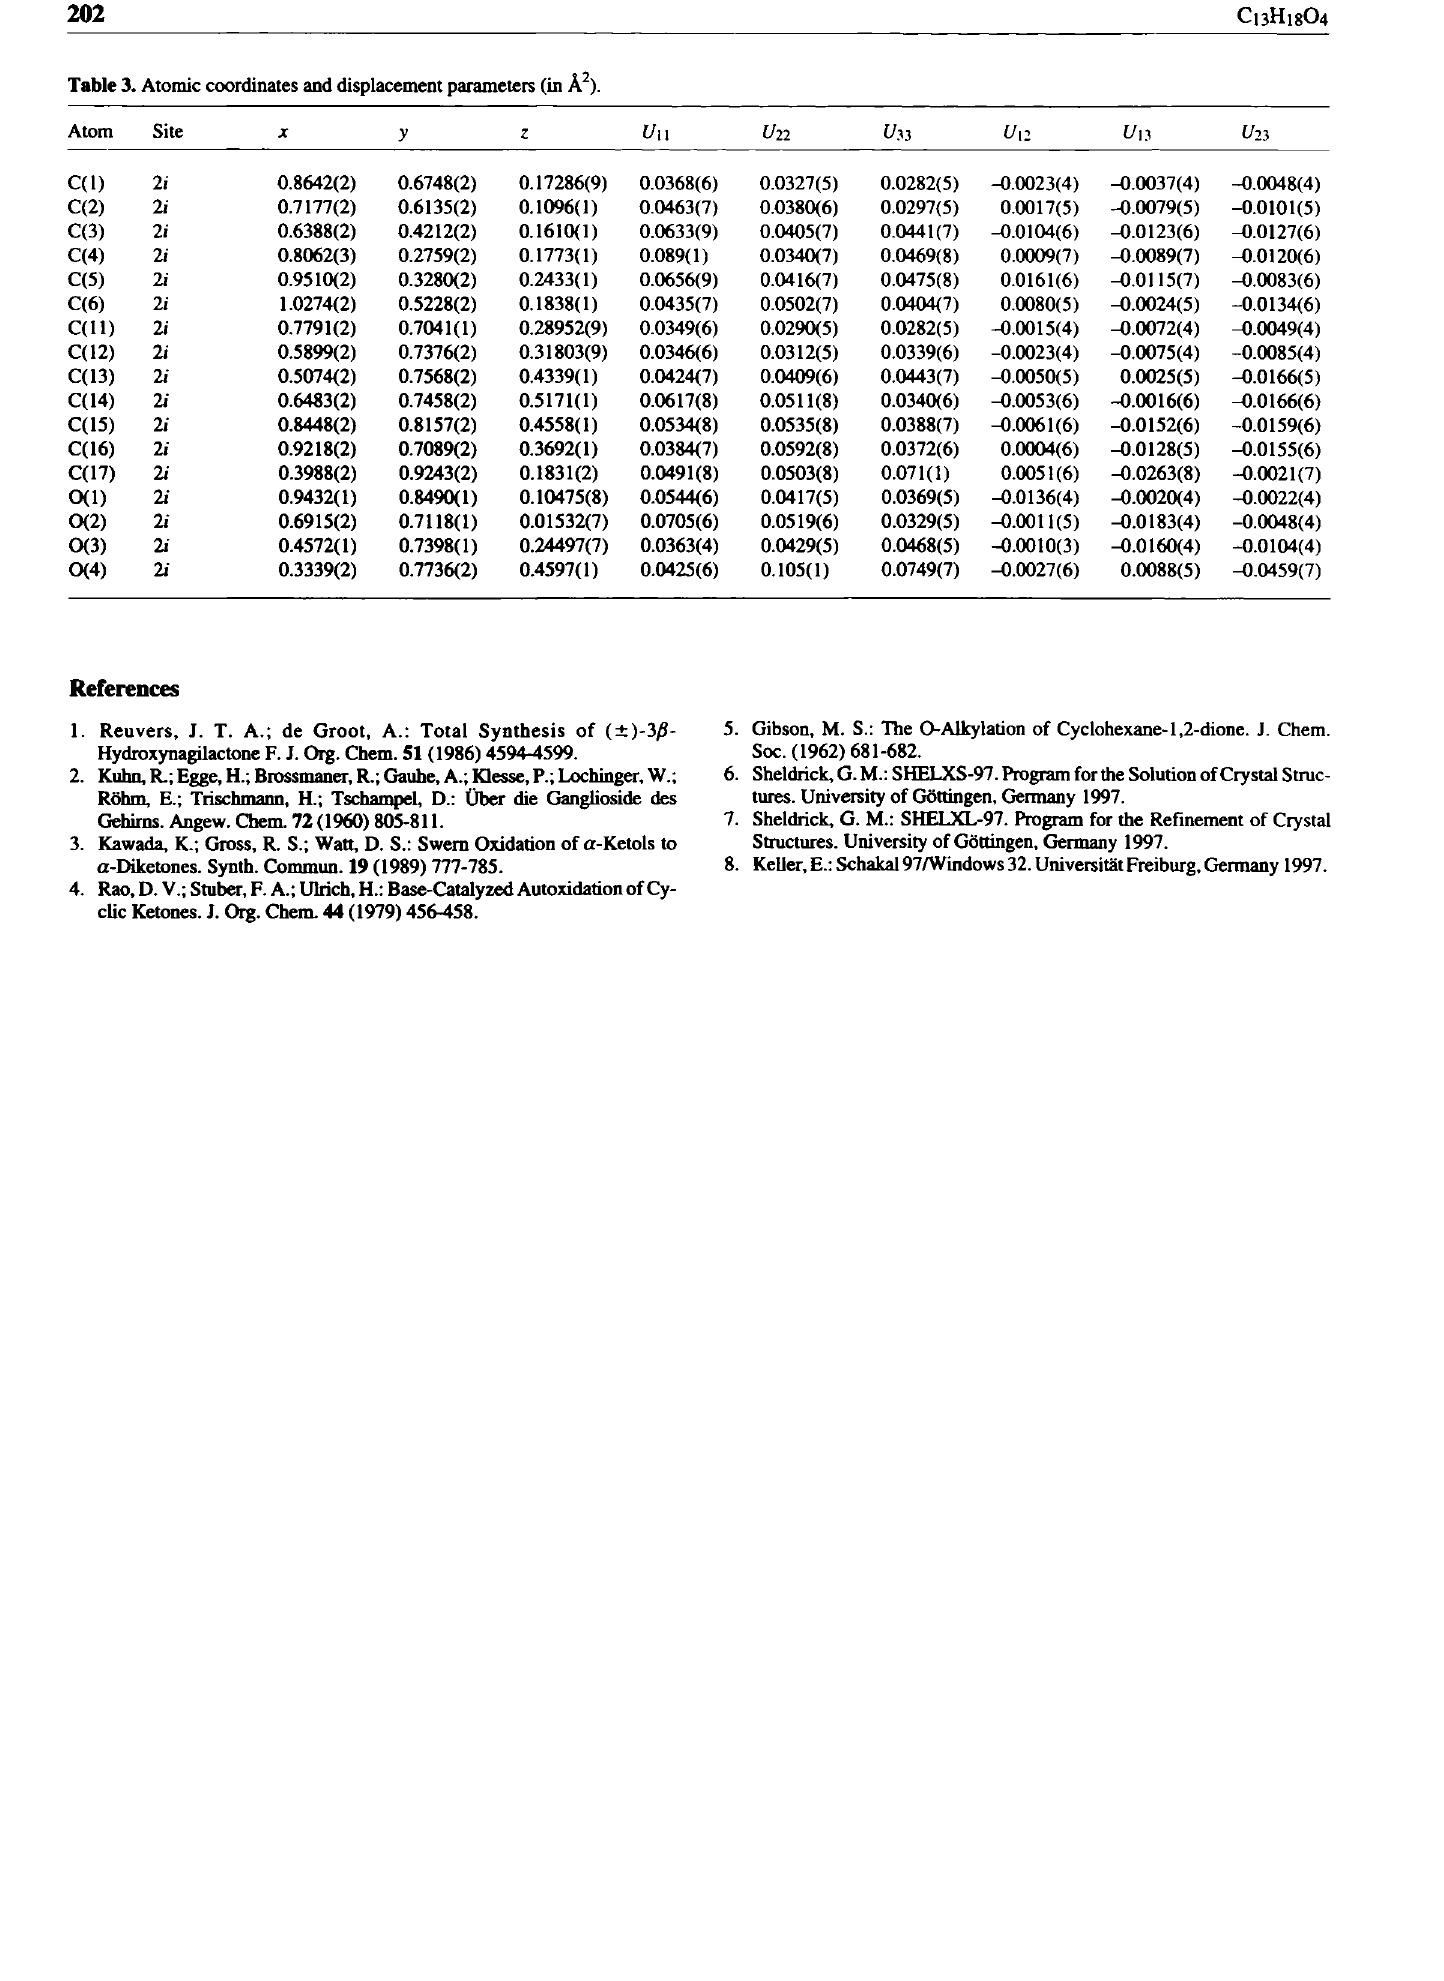
Table 3. Atomic coordinates and displacement parameters (in Â 2